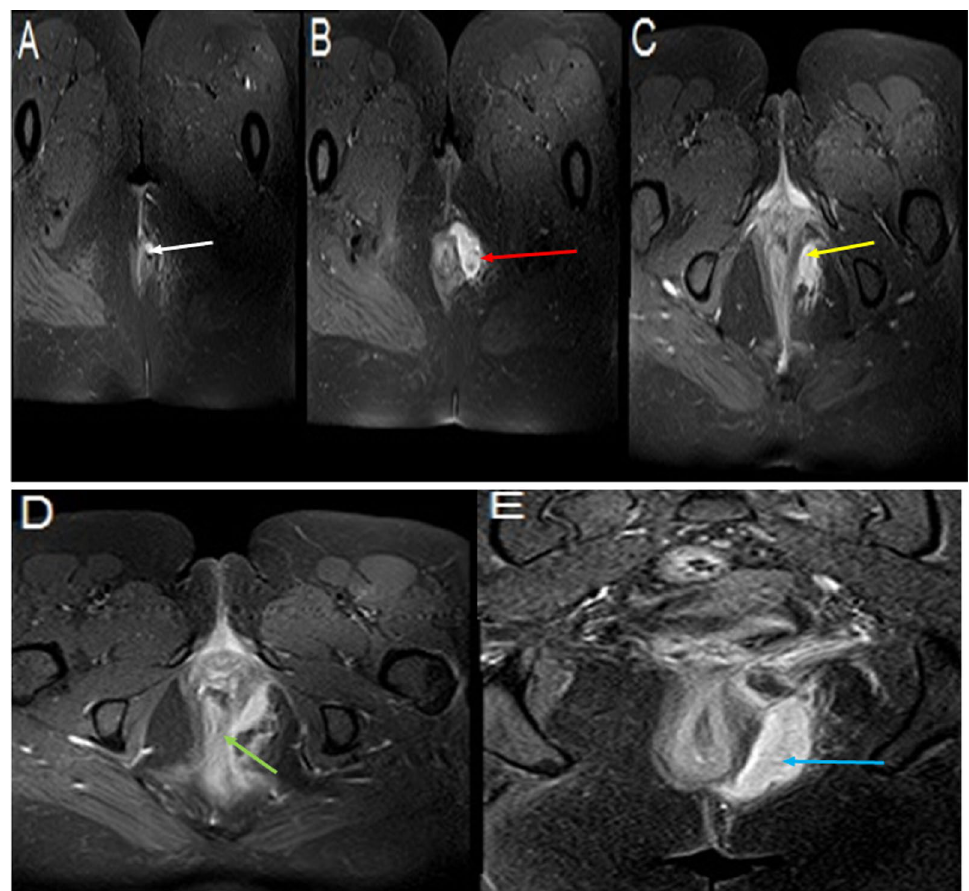
Fig. 7 A 35-year-old female patient presented with left perianal discharge. She was diagnosed clinically with a perianal abscess. Therefore, from the start, we injected IV contrast material. MRI examination after IV contrast injection revealed in enhanced axial T1 FATSAT images ( A – D ): A External cutaneous opening of the fistulous tract in the left perianal region (white arrow). B Distended cavity with peripheral enhancement at the left ischioanal fossa denoting abscess formation (red arrow). C An abscess ascending upward and piercing the left levator ani muscle with supralevator extension (yellow arrow). D Internal mucosal opening at the anorectal junction at four o’clock (green arrow). E Enhanced coronal T1 FATSAT image shows the course of the left extrasphincteric fistula (blue arrow). The final diagnosis was a left, grade V, extrasphincteric